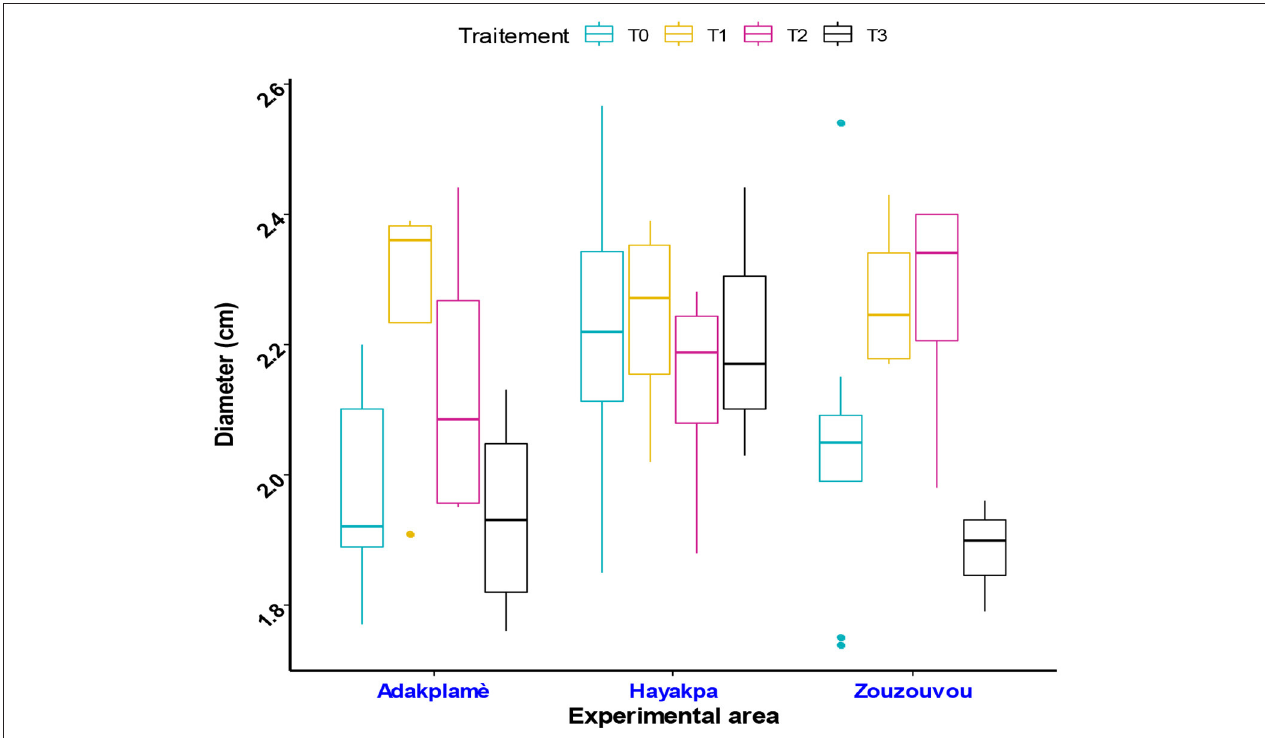
FIGURE 4 | Stem diameter of maize plants as a function of zone treatments. T 0 :100% NPK + urea; T 1 : clay + P. putida + ½ NPK + Urea, T 2 : peat + P. putida + ½ NPK + Urea, T 3 : clay-peat + P. putida + ½ NPK +